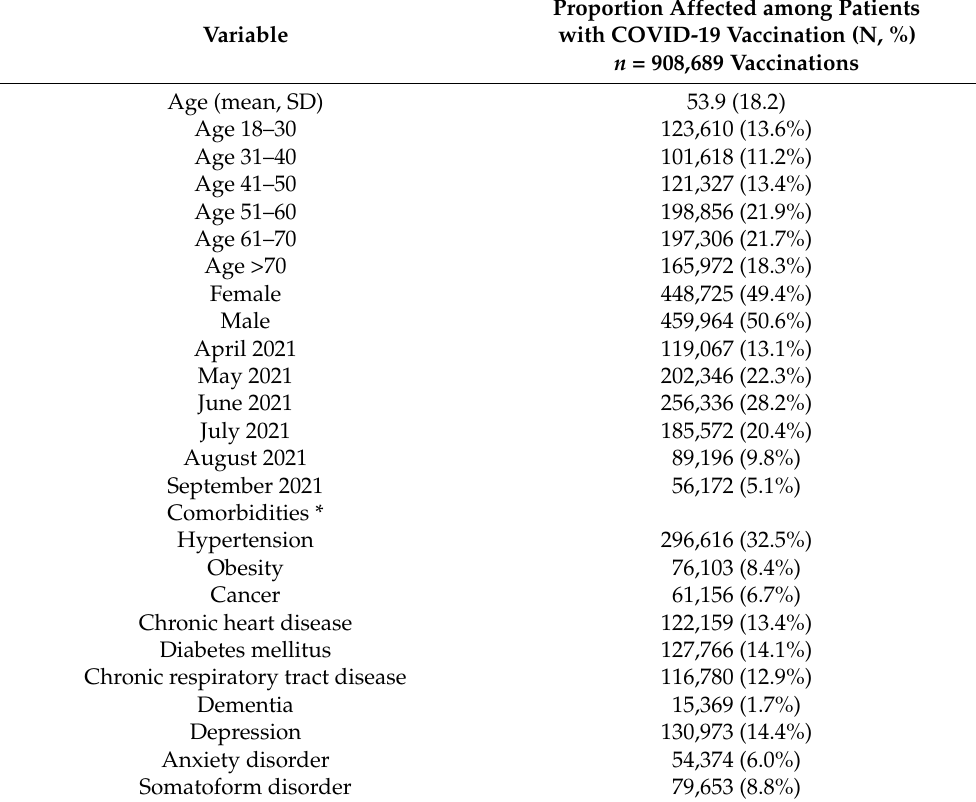
Table 1. Baseline characteristics of the study